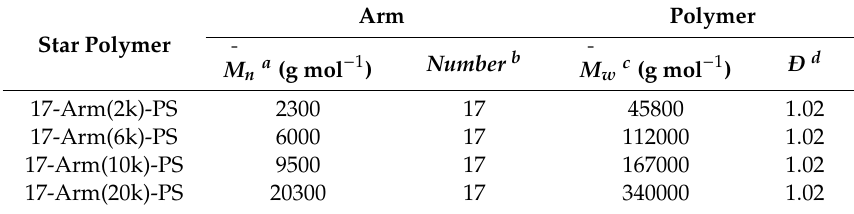
Table 1. Molecular characteristics and thermal properties of 17-armed star polystyrenes.